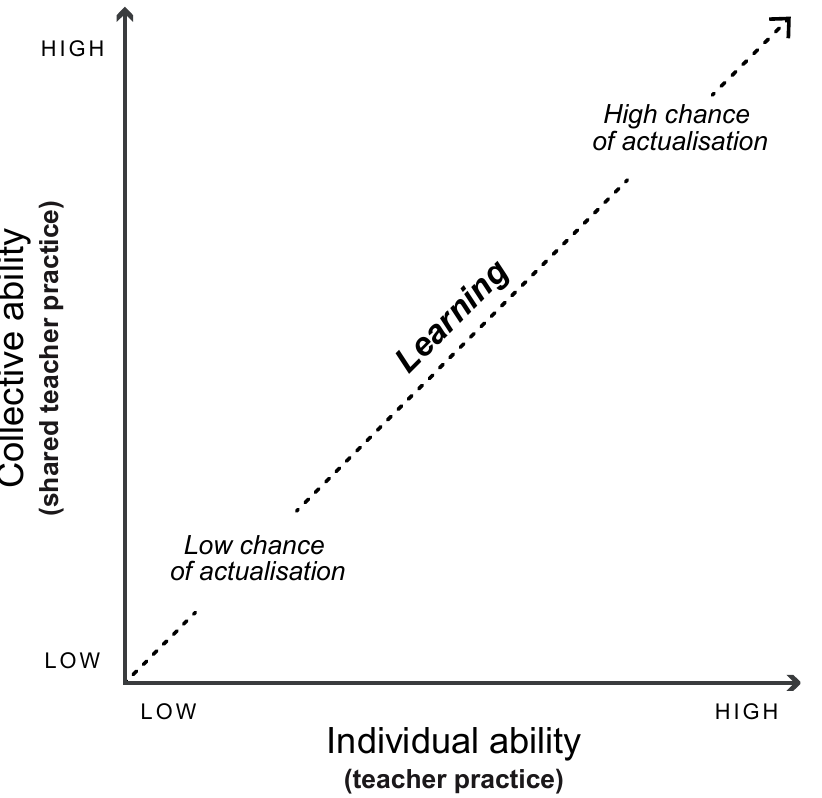
Figure 8. Affordance actualisation relative to individual and collective teacher practice [42].